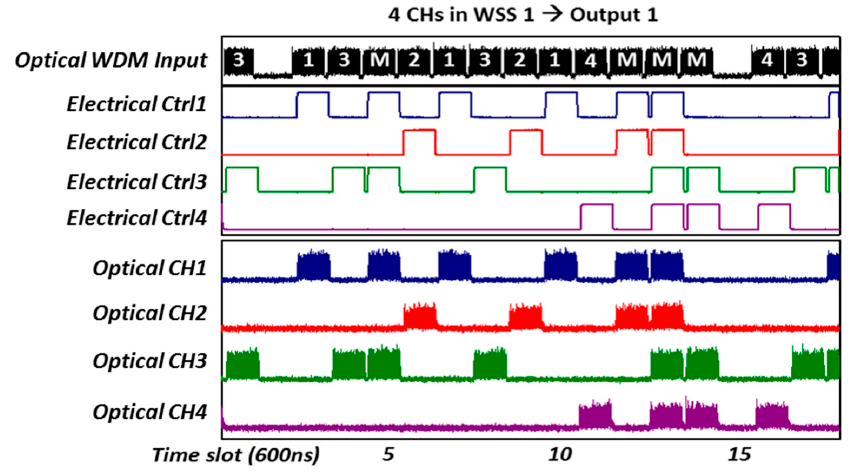
Figure 9. Traces for four channels in WSS1 destined to Output 1.